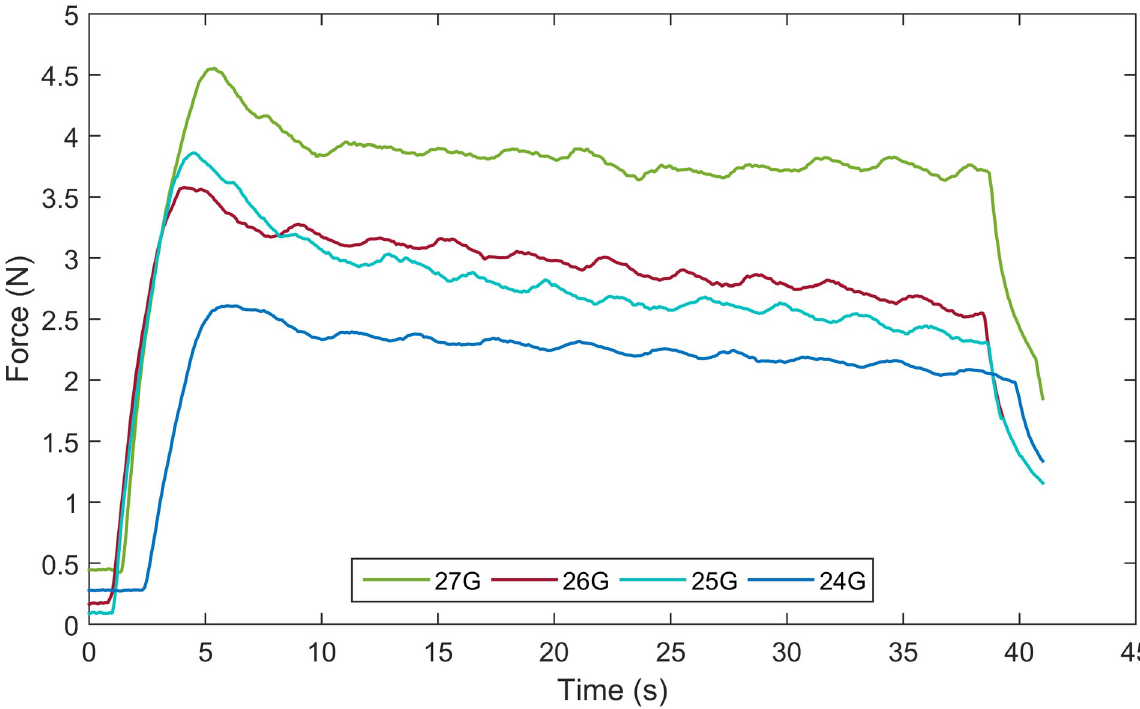
Fig 10. Experimental result of the submucosal injection force with needles of various sizes.